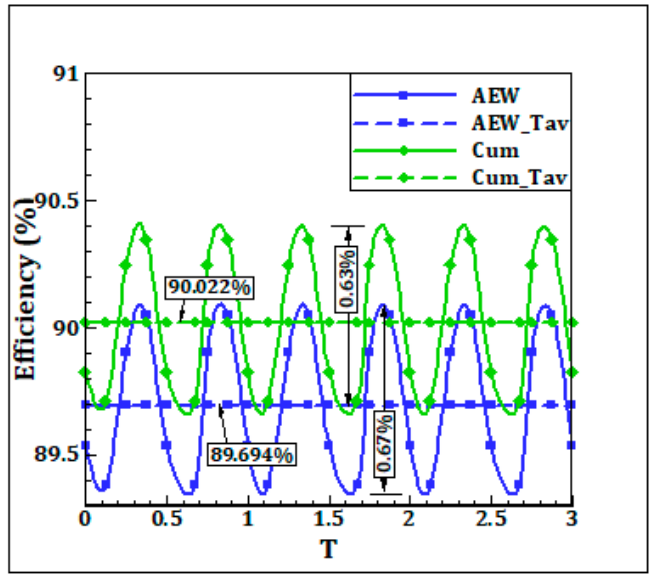
Figure 19. E ffi ciency fluctuation at the di ff erent physical Figure 19. Efficiency fluctuation at the different physical time.